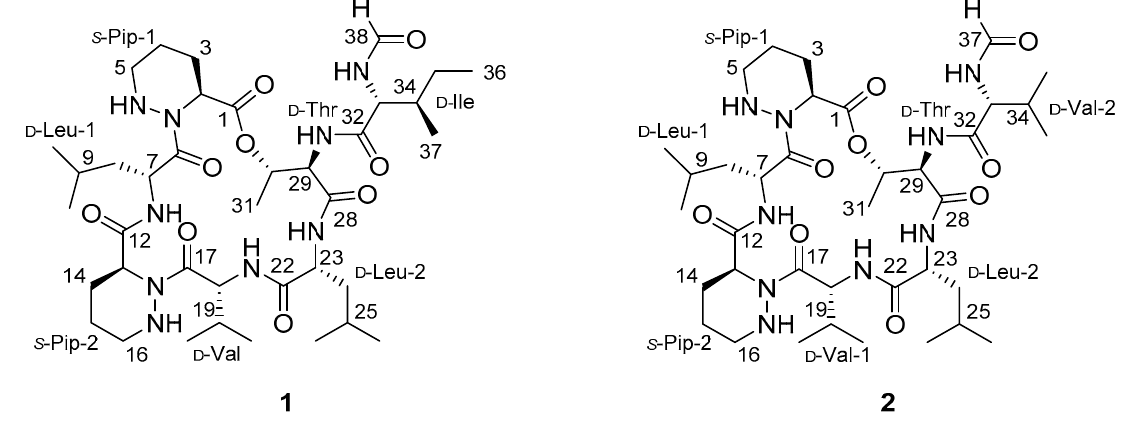
Figure 1. The chemical structures of depsidomycins B and C ( 1 and 2 ).